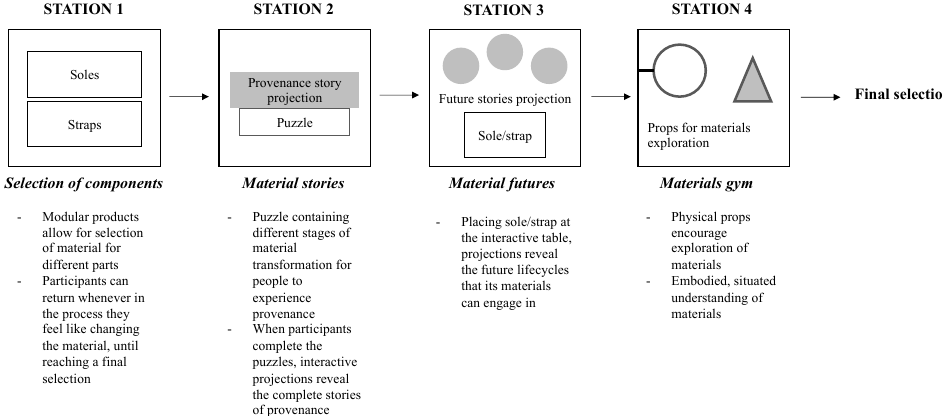
Figure 8. Schematics of the process of The Compositor Tool.